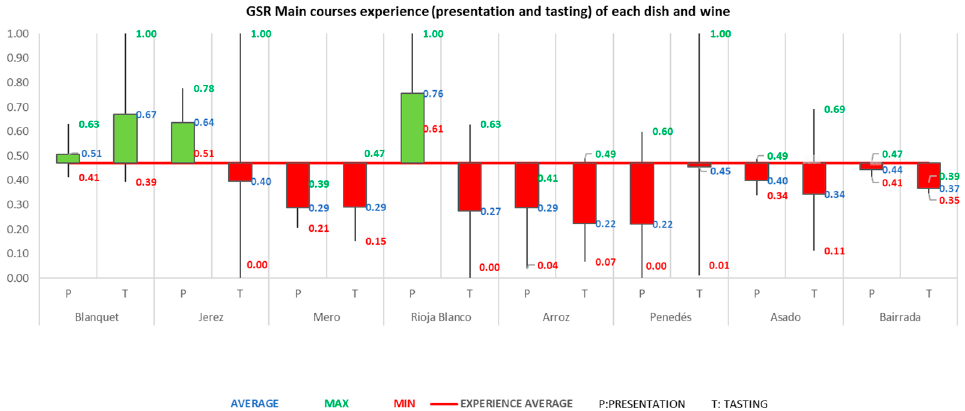
Figure 4. Galvanic skin response analysis for each dish and wine (presentation and tasting): Main courses group. Source: Original work from the authors.